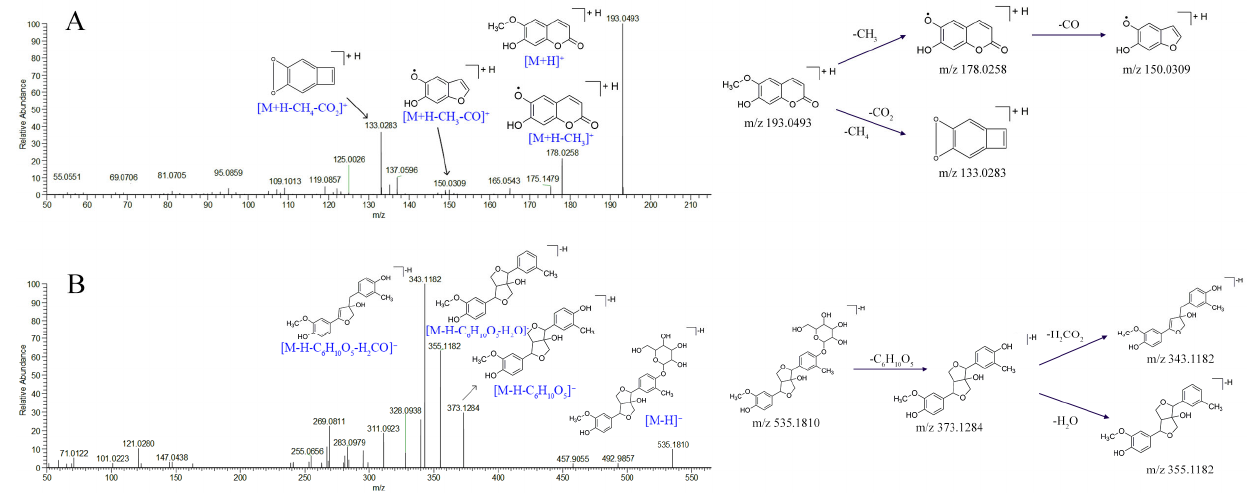
Figure 4. Characteristic of MS/MS spectra and possible fragmentation pathways of scopoletin ( A ) and hydroxylpinoresinol 4 ′‐ O ‐ glucopyranoside ( B